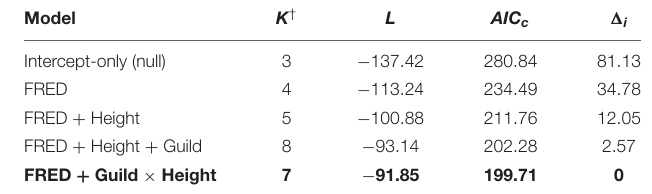
† See Table 5 footnotes for meaning of column headings.